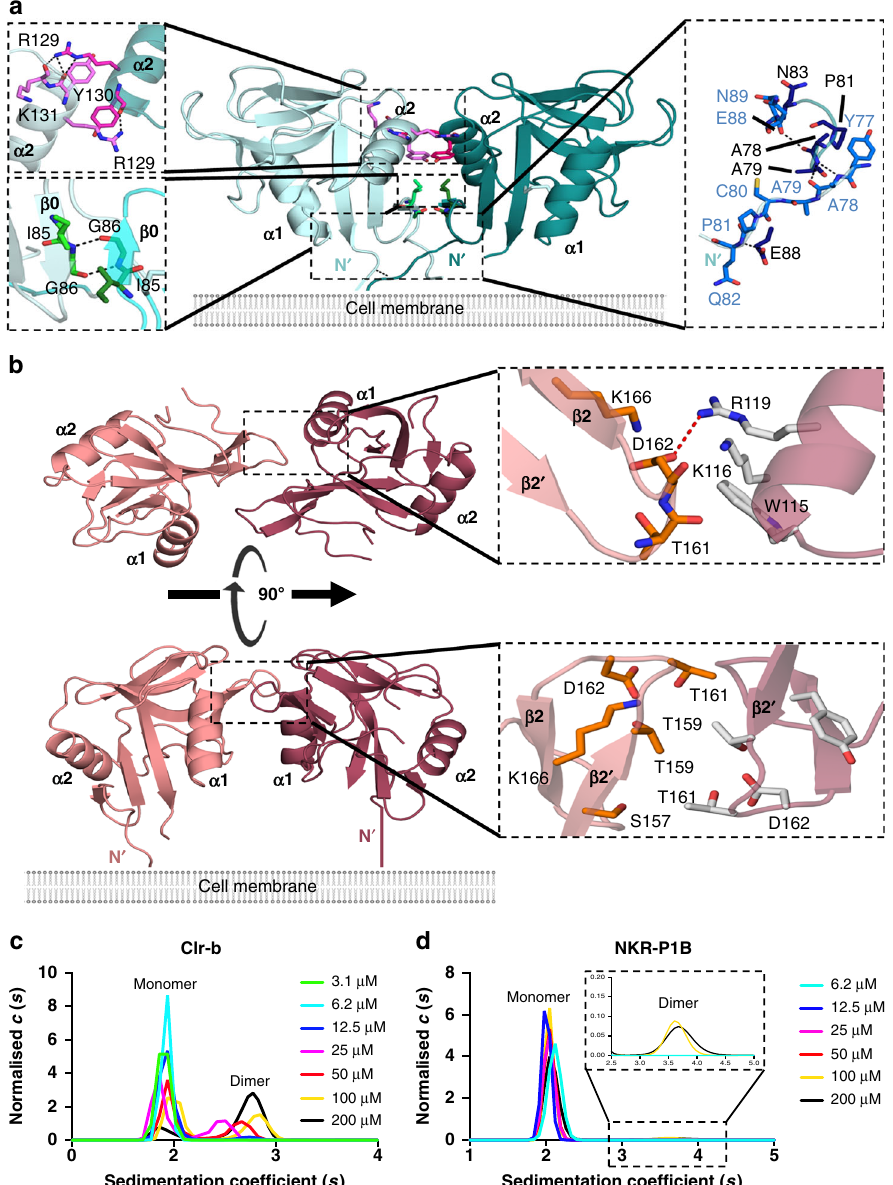
Fig. 2 Clr-b and NKR-P1B self-association. a Overview of the Clr-b homodimer. Detailed interactions within the head, body, and tail regions are shown in shades of pink, green and blue respectively. Hydrogen bonds are represented as black dotted lines. b Overview of the non-classic NKR-P1B homodimer. Salt-bridges are shown as red dotted lines. c , d Sedimentation velocity analytical ultracentrifugation analysis of Clr-b ( c ) and NKR-P1B ( d ) self-association. The sedimentation coef fi cient distributions [c( s )] for a dilution series of each protein are shown as indicated. A magni fi ed version of the NKR-P1B dimeric species is provided within the dashed